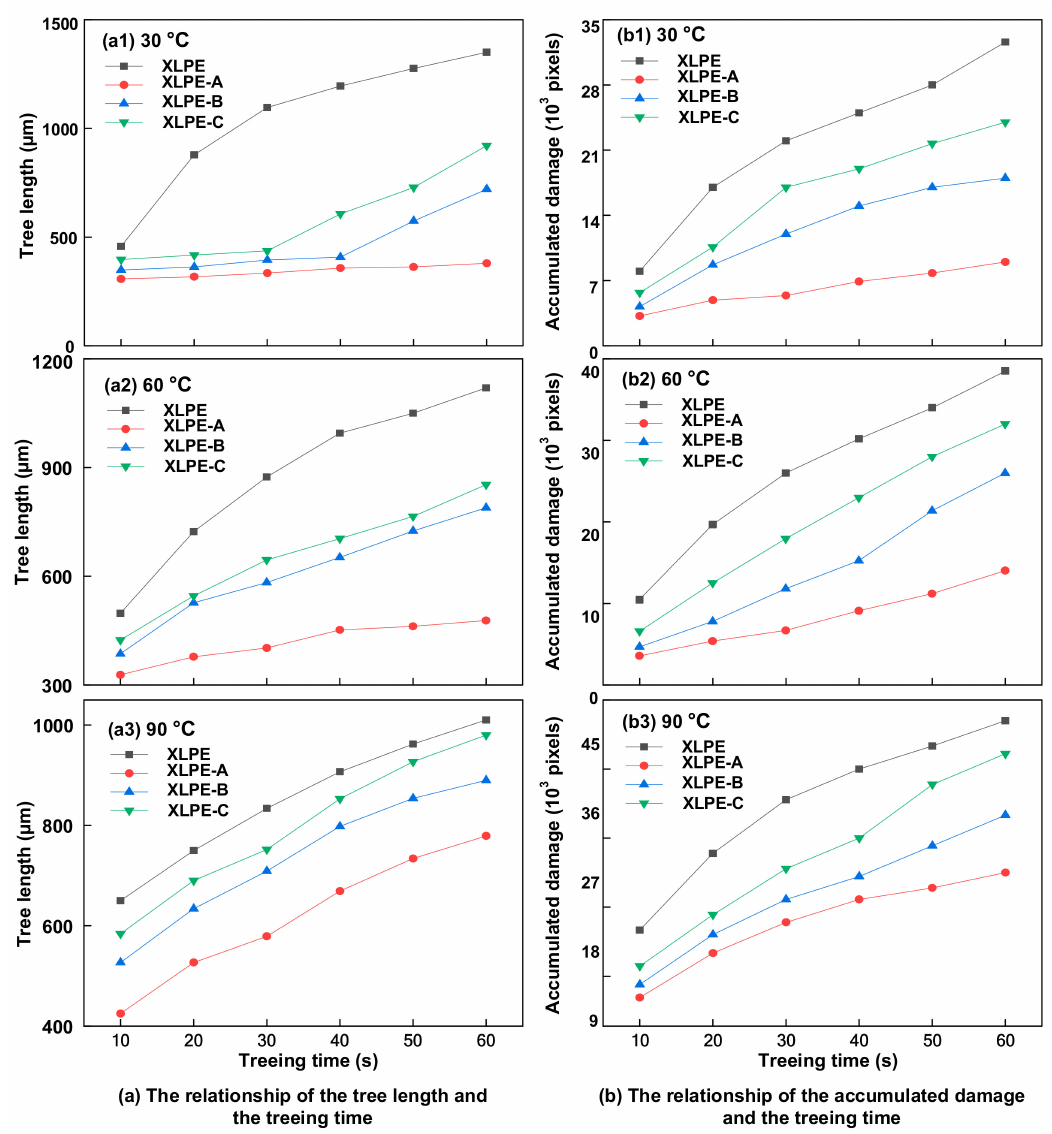
Figure 5. Electrical treeing characteristics with the same polarity DC-impulse